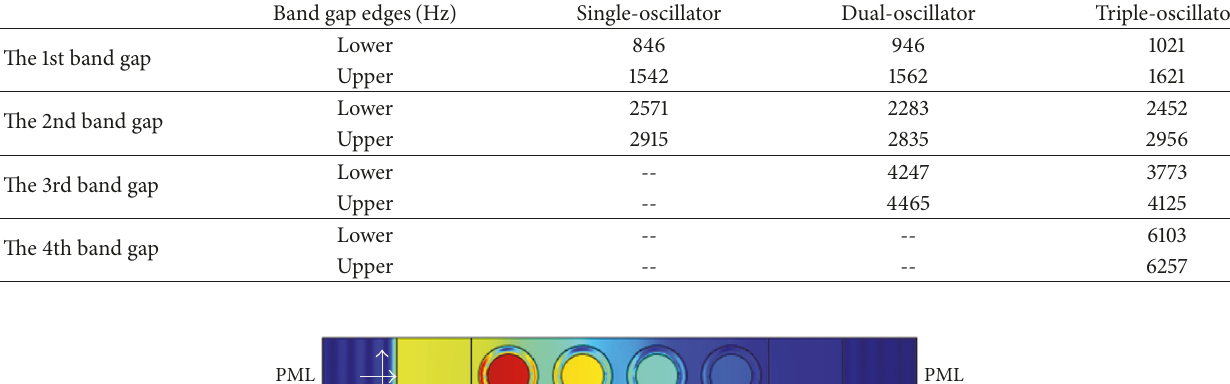
Table 3: Band gaps of single-, dual-, triple-oscillator systems.